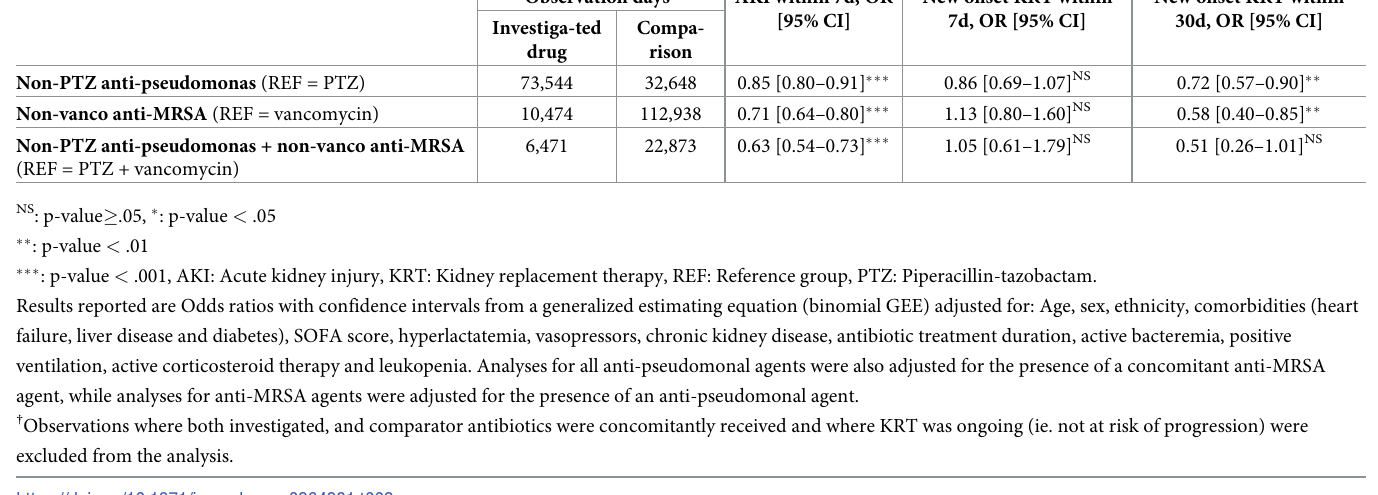
Table 2. Risk of new or worsening AKI and KRT associated with exposure to various anti-pseudomonas, anti-MRSA or their combination (multivariate). Observation days †